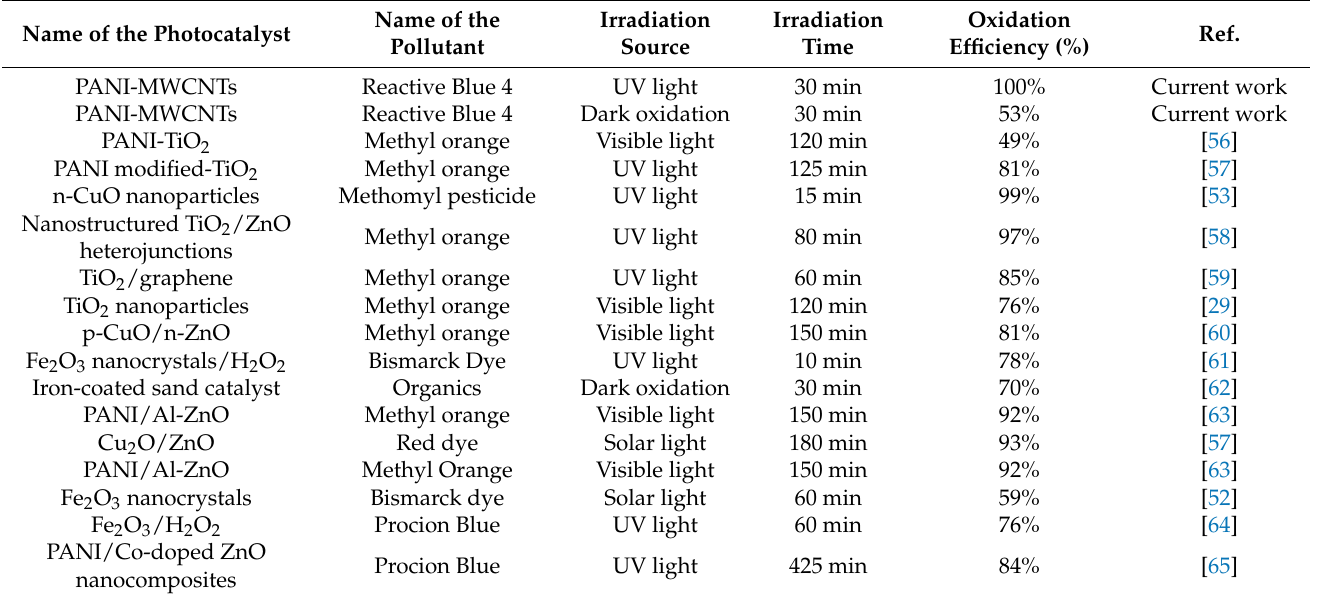
Table 2. Comparison of the oxidation boundaries using different photocatalysts under dark, visible and ultraviolet (UV) light irradiation for the removal of various pollutants.